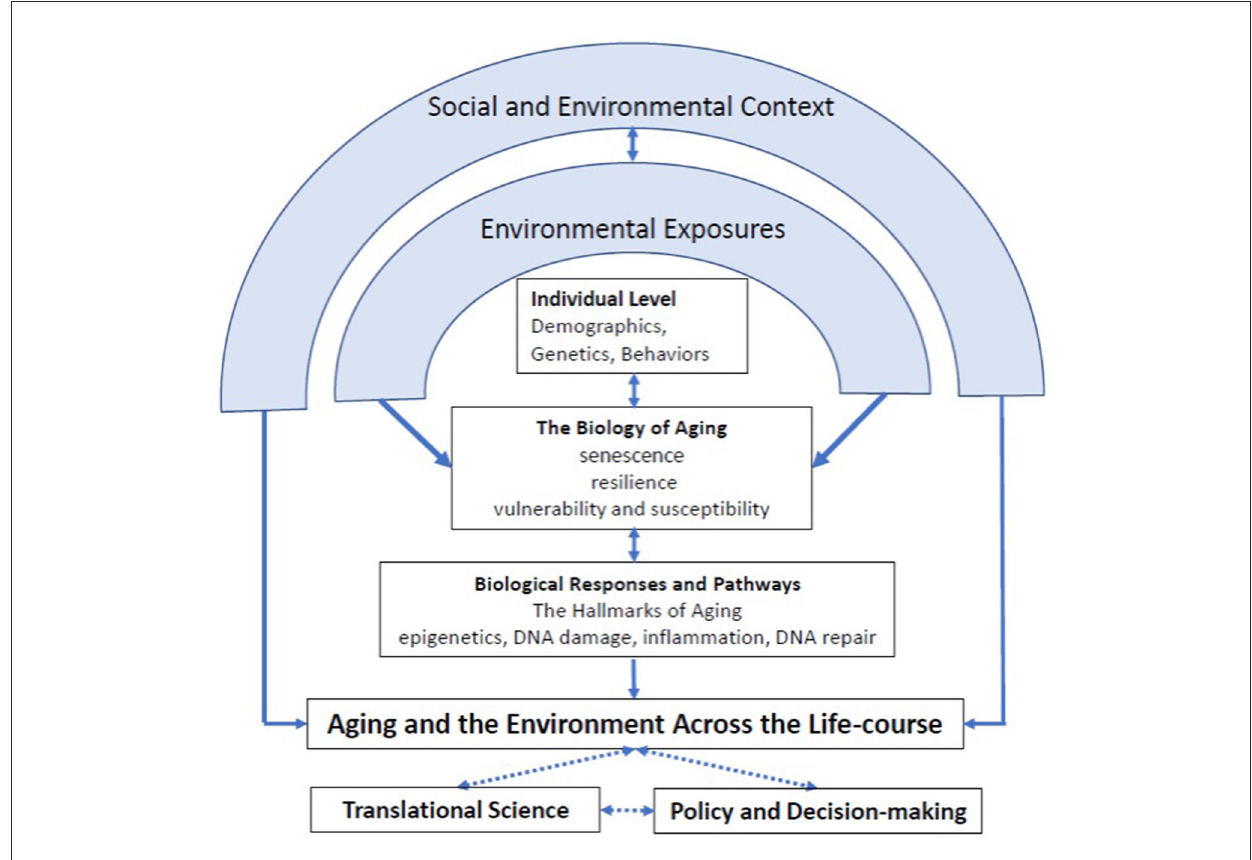
FIGURE1 Integrating aging and environmental health